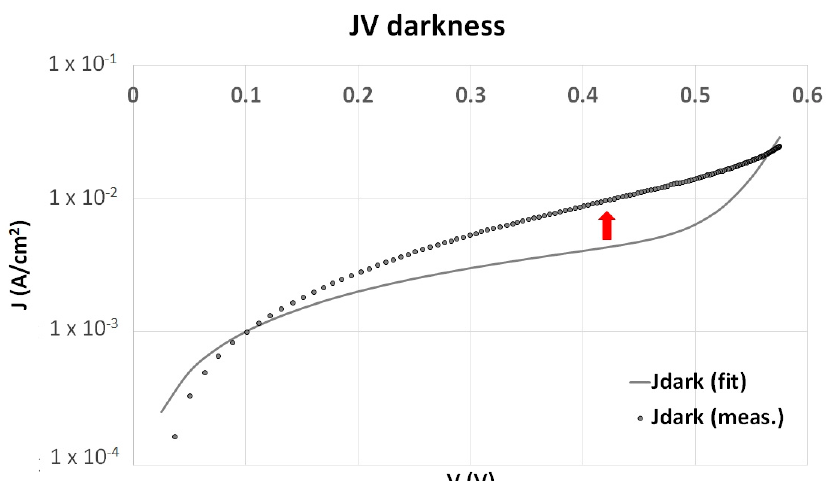
Figure 9. Measured darkness (recombination) JV curve (meas.) showing a hump and the fitting es- (fit.) using the two-diode model (J 01 = 5 × 10 − 12 A/cm 2 , J 02 = 1 × 10 − 8 A/cm 2 , R P = 100 Ω · cm 2 , say (fit.) using the two-diode model (J 01 = 5 × 10 − 12 A/cm 2 , J 02 = 1 × 10 − 8 A/cm 2 , R P = 100 Ω ·cm 2 , R S = 1 R S = 1 m Ω · cm 2 and J PH = 26 mA/cm 2 ; these are the parameter values obtained for the best fit, m Ω ·cm 2 and J PH = 26 mA/cm 2 ; these are the parameter values obtained for the best fit, RMSE = 21.38). RMSE =